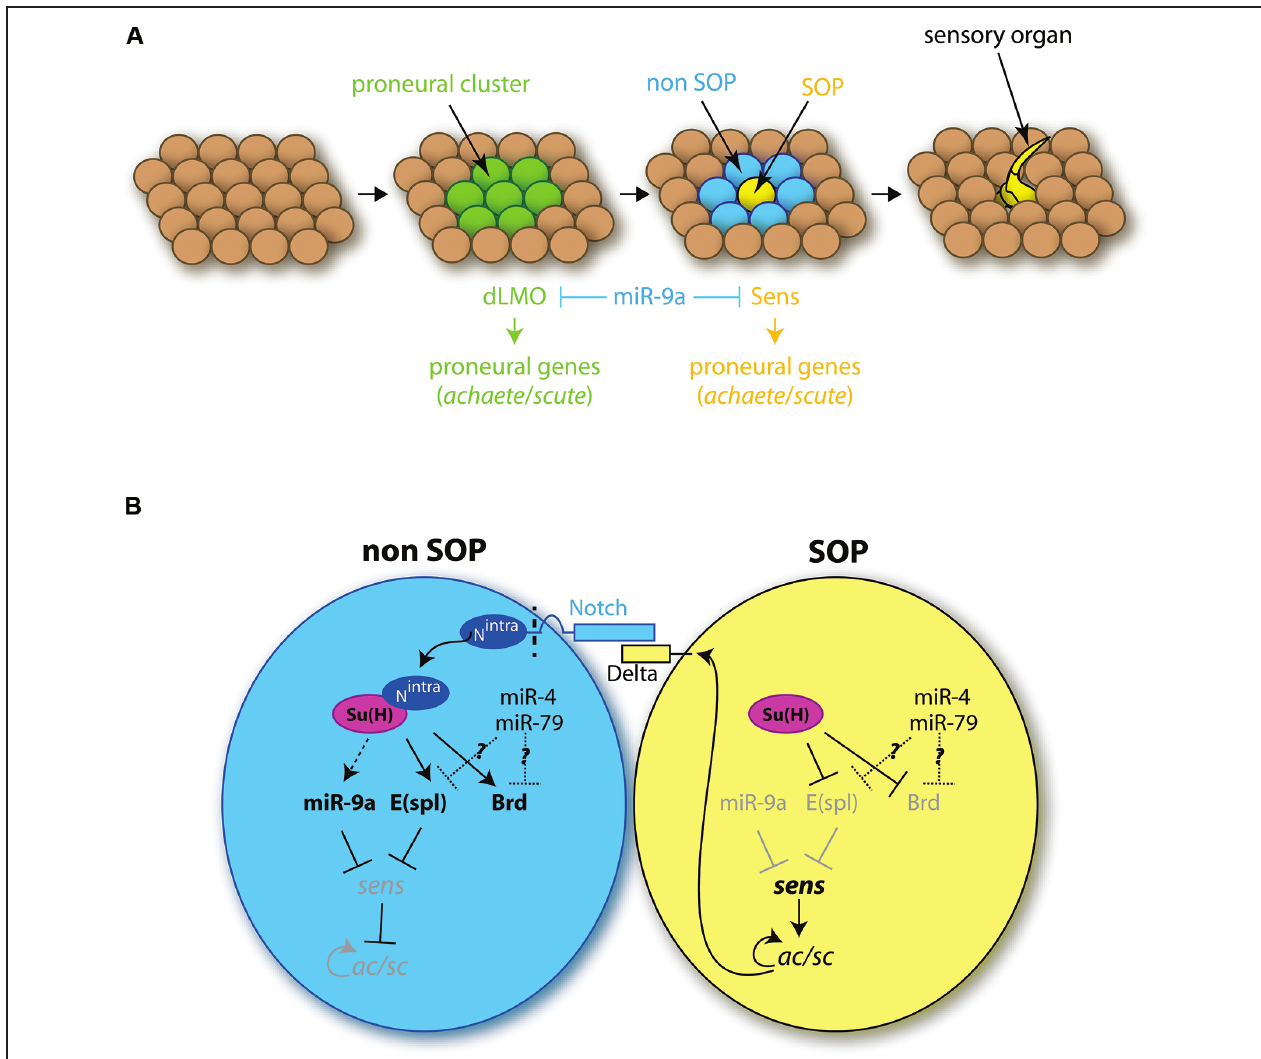
cells. This interaction leads to Notch cleavage, which releases Notch intracellular domain (N intra ) in non-SOP cells. N intra interacts with the transcription factor Suppressor of Hairless Su(H), which induces E(spl) gene expression. E(spl) genes encode transcriptional repressors inhibiting the expression of proneural genes and in particular sens . In the SOP cell, in the absence of N intra , Su(H) has an inhibitory effect on the transcription of E(spl) genes which allows for the expression of sens . Sens activates the expression of proneural genes of the ac / scute complex ( ac/sc ) which specify the SOP cell fate. miR-9a, expressed in non-SOP cells, prevents ectopic expression of sens , thereby conferring robustness to the developmental program. Other genes of the miR-9 family might also play a role here, as miR-4 and miR-79 have been shown to regulate the expression Notch target genes, such as E(spl) or Brd